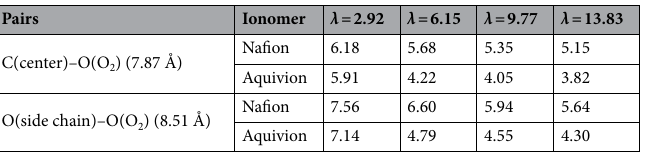
Table 2. The coordination numbers of Nafion and Aquivion on a Pt surface at 353.15 K, where the water contents ( λ ) were varied.